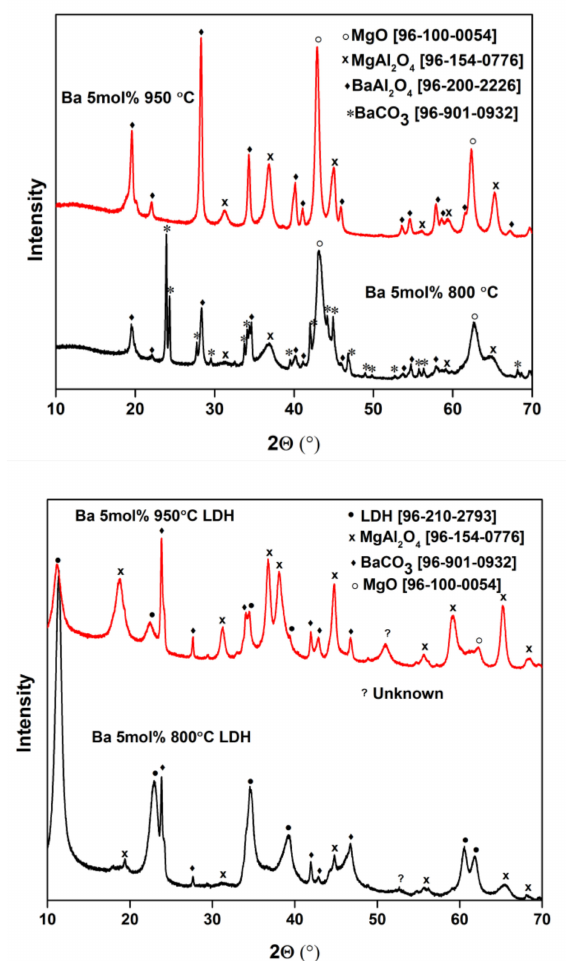
Figure 5. XRD patterns of mixed metal oxides (MMO) obtained by heating the Mg 1.95 Ba 0.05 / Al 1 precursor gels at 800 ◦ C and 950 ◦ C ( top ) and reconstructed Mg 1.95 Ba 0.05 / Al 1 LDHs ( bottom ).